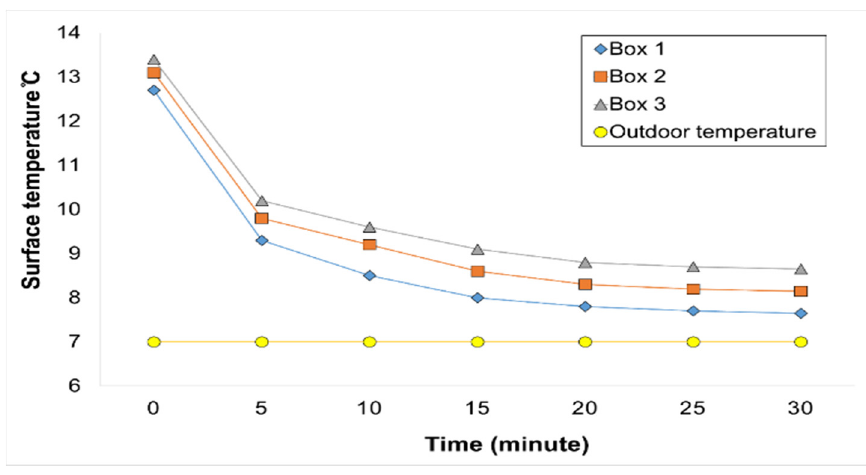
Figure 5. Variation of the surface temperature over time at 60 Pa (Day 3).